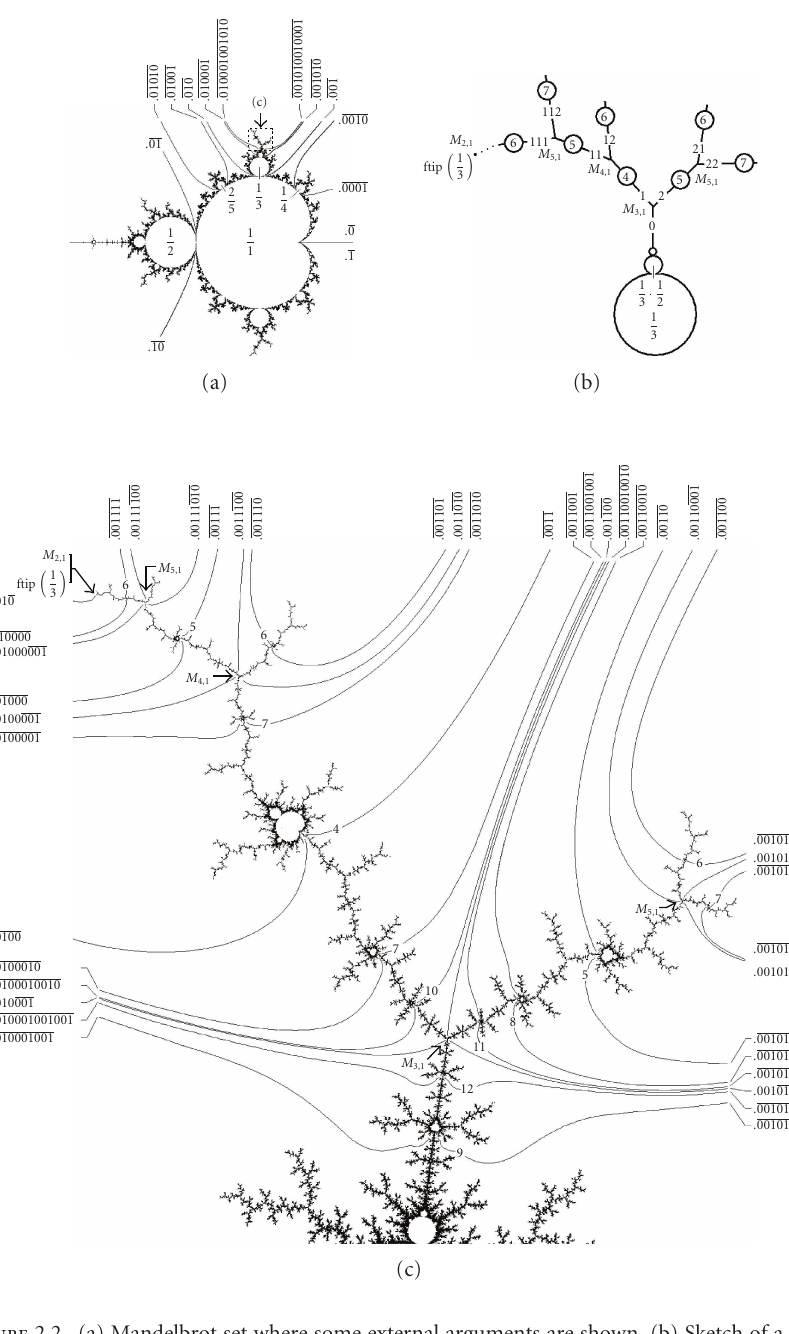
Figure 2.2 . (a) Mandelbrot set where some external arguments are shown. (b) Sketch of a primary shrub, shrub (1/3). (c) Magnification of the rectangle of (a) showing the shrub (1/3). Some external arguments of notable components and Misiurewicz points are